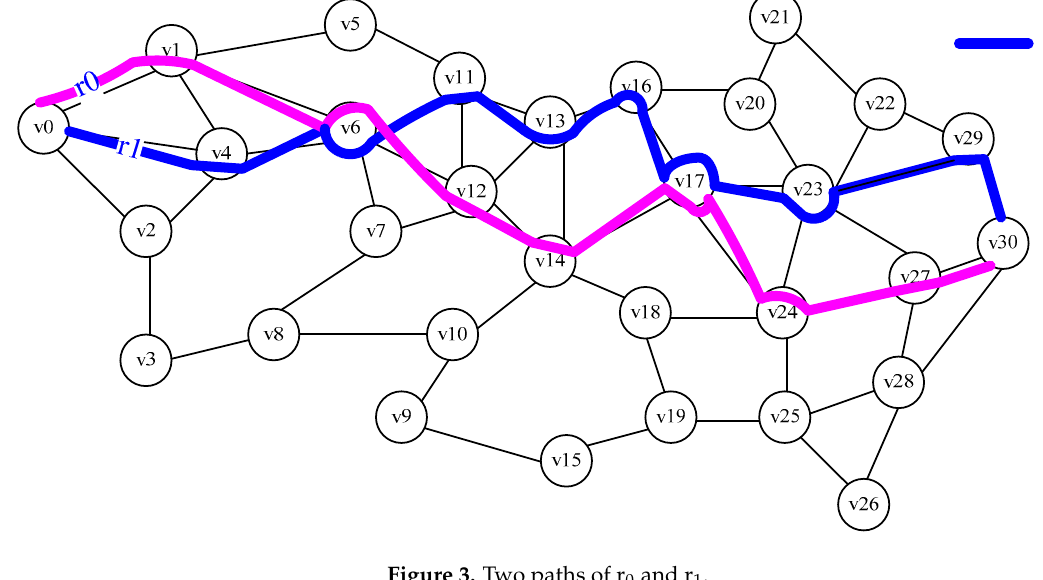
Figure 3. Two paths of r 0 and r 1 .